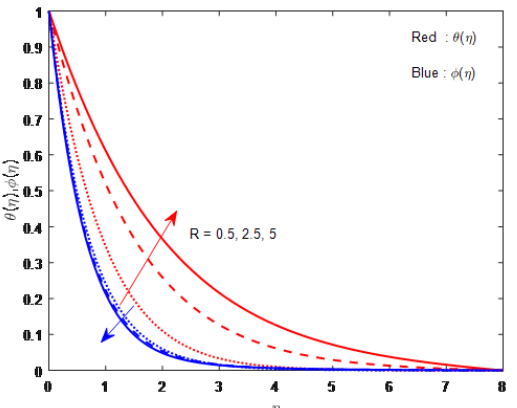
Figure 11: Temperature and concentration profiles for different val- ues of unsteadiness parameter A